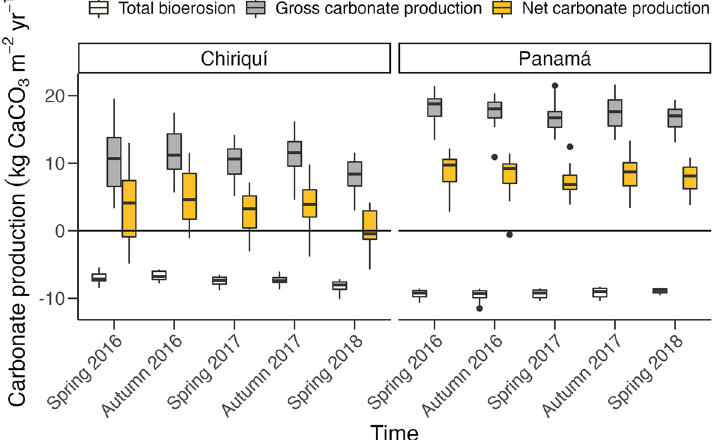
Figure 3. Boxplot of median (± interquartile range) gross carbonate production (gray boxes), total bioerosion (white boxes), and net carbonate production (yellow boxes) for each gulf across the five surveys from 2016– 2018. All of the rates are reported in kg CaCO 3 m −2 year −1 . The black horizontal line delimits the division between net production and net erosion. Black points represent statistical